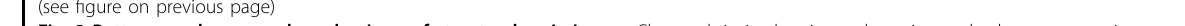
Fig. 3 Patterns and proposed mechanisms of structural variations. a Chromothripsis, showing a shattering and subsequent repair process. Telomere crisis and/or micronuclei by chromosome mis-segregation may induce chromothripsis. b Chromoplexy, showing a “ closed chain ” (upper) in the Circos plot. This is a multi-chromosomal translocation (lower). c MMBIR by template switching of the replication machineries. d BFB cycle, showing subtelomeric copy number increases and fold-back inversions. Proposed mechanisms are shown below. e Different patterns of SVs in BRCA1 - and BRCA2 -mutant breast cancers. f Patterns and formation of DMs and neochromosomes. DNA fragments can self-ligate, forming a ring structure, and are ampli fi ed (DMs). Fragments capturing centromeres and telomeres become neochromosomes. g Patterns and processes of L1 retrotransposition in the cancer genome. h HPV integration and regional rolling-circle ampli fi